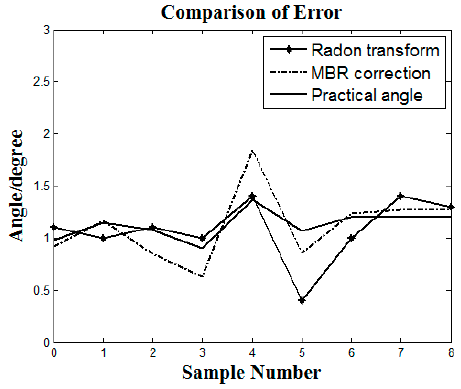
Figure 11. Comparison of error.